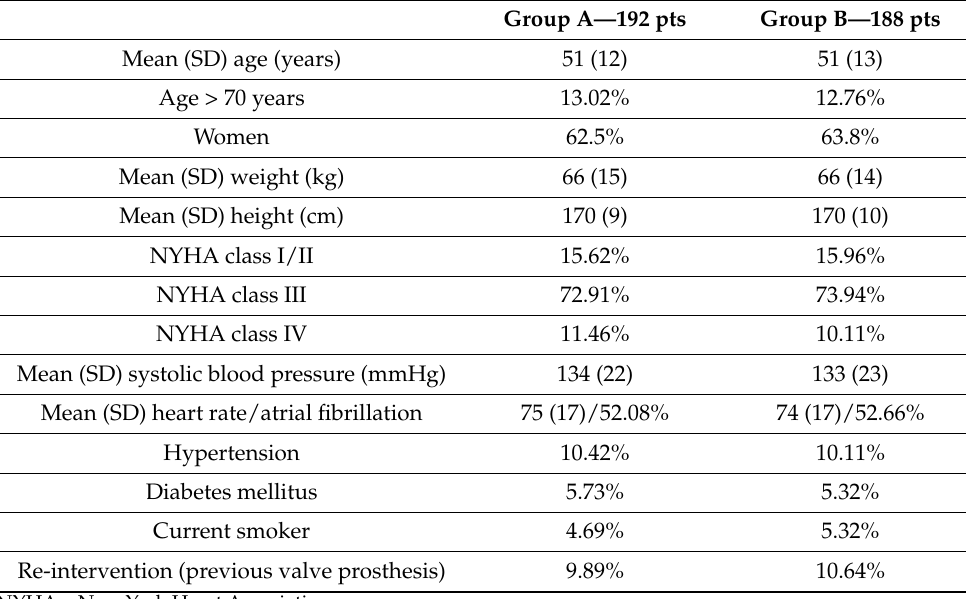
Table 2. Baseline characteristics of the study